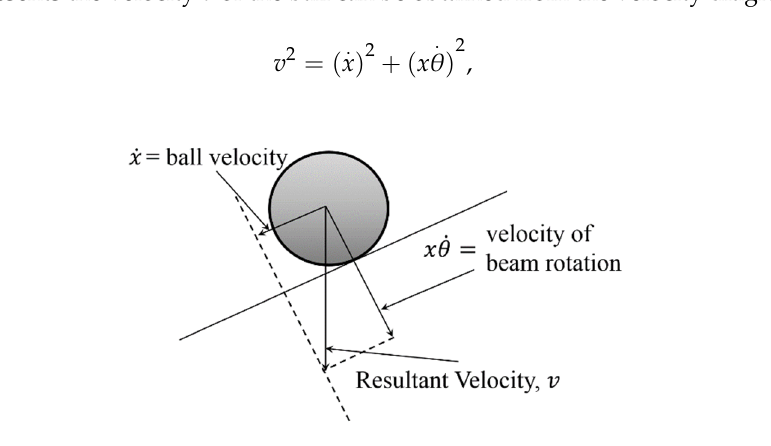
Figure 4. Ball velocity diagram.